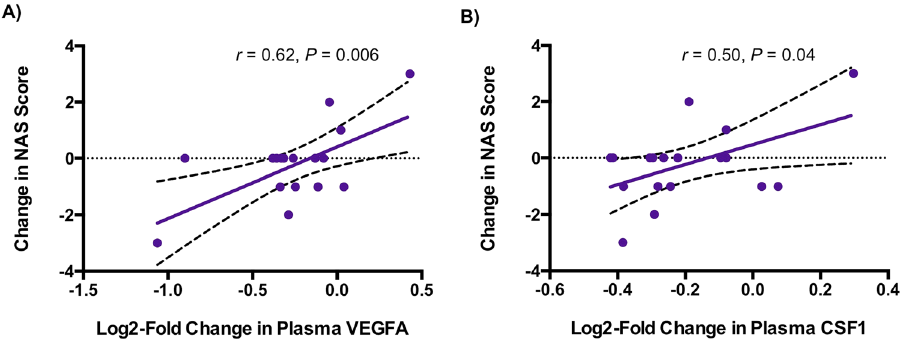
Figure 3. Relationship of Changes in Plasma VEGFA and CSF1 with Change in NAS Score in Tesamorelin- Treated Participants. Within the tesamorelin-treated arm, reductions in plasma (A) VEGFA ( r = 0.62, P = 0.006) and (B) CSF1 ( r = 0.50, P = 0.04) were associated with a decrease in NAS score. Linear regression lines with 95% confidence intervals are shown. Abbreviations: CSF1, macrophage colony stimulating factor 1; NAS, NAFLD activity score; VEGFA, vascular endothelial growth factor A.